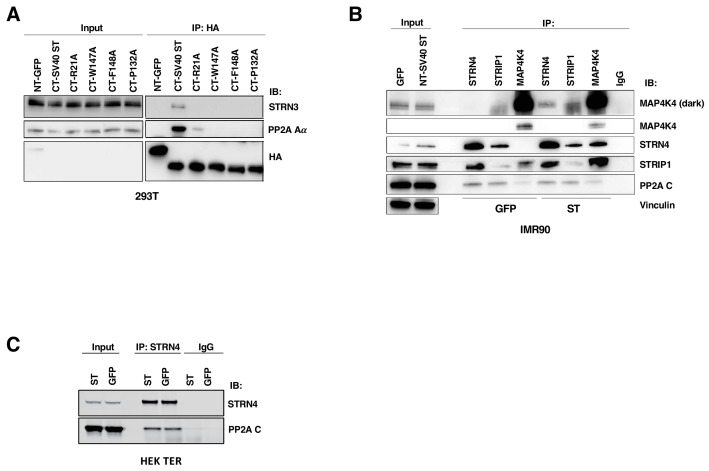
Changes in MAP4K4-STRIPAK interactions with ST expression.(A) Co-immunoprecipitation analysis in 293T cells of CTAP-tagged SV40 ST wild-type and PP2A binding mutants. Co-immunoprecipitation of STRN3 and Aα is shown. (B) Co-immunoprecipitation analysis of STRN4, STRIP1, PP2A Cα, and MAP4K4 in IMR90 cells in the presence of SV40 ST or GFP. (C) Co-immunoprecipitation analysis of STRN4 and PP2A C subunit. (D) In vitro kinase assay of tandem-affinity purified MAP4K4 (Flag/HA) from HEK TER cells expressing either ST or GFP was performed and MBP was used as a substrate. HA and phospho-MBP were detected by immunoblotting.